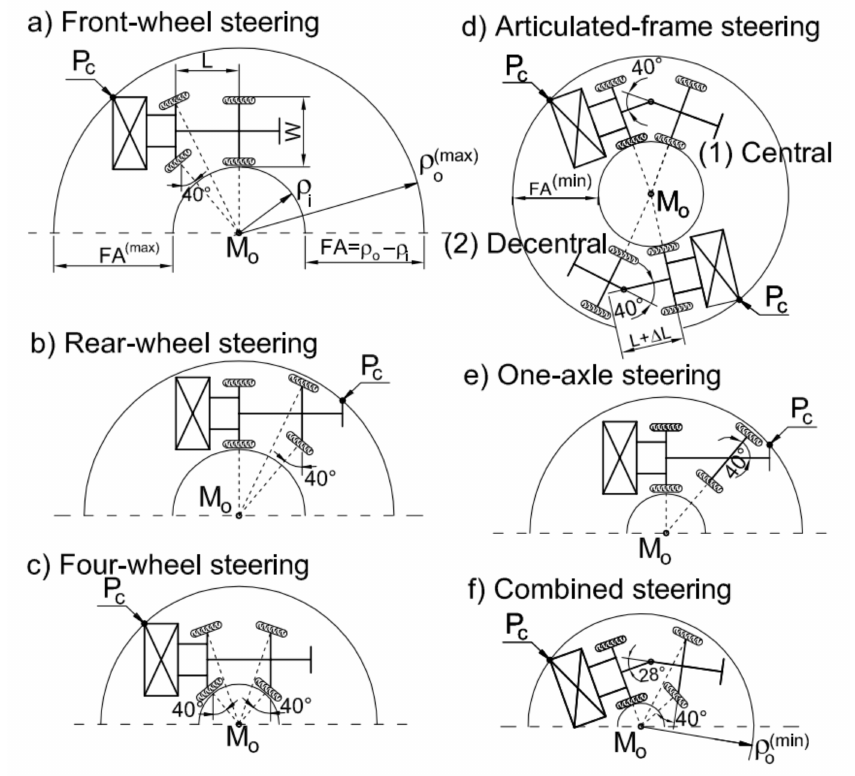
Figure 1. Comparison of the manoeuvrability of wheeled loaders with different undercarriage configurations in terms of steering systems